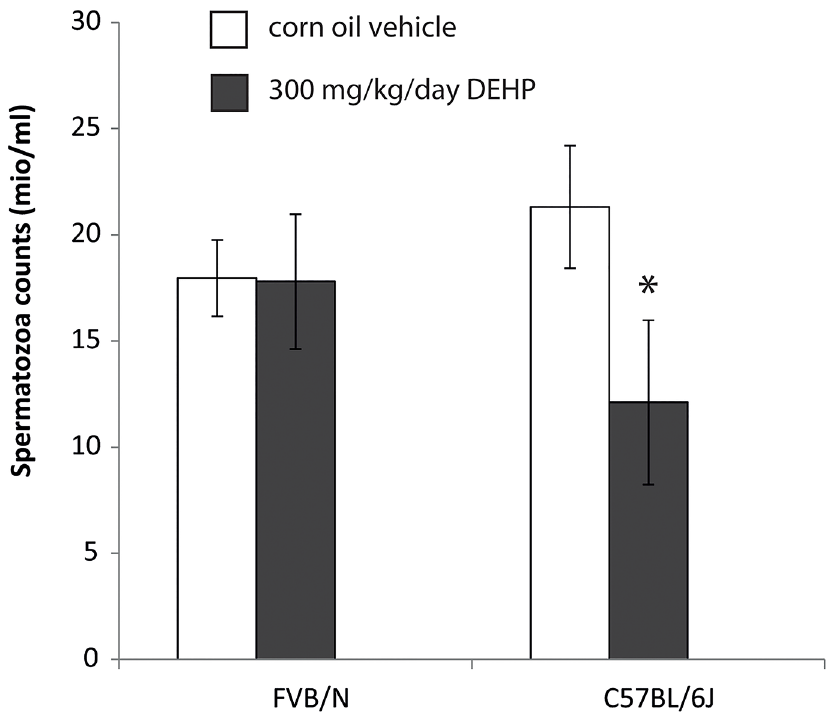
Fig 1. Production of spermatozoa in 8 weeks-old F1 males prenatally exposed to DEHP. Histogram plot showing on the y-axis the spermatozoa count expressed as millions spermatozoa per milliliters (mio/ml) recorded from sperm of F1 males mice, and on the x-axis, the two genetic backgrounds studied with either prenatal exposure to 300 mg/kg/day DEHP diluted in corn oil (gray bars), or corn oil vehicle only (white bars). Prenatal exposure consists of oral administration during pregnancy days 9 to 19 to the pregnant mice childbearing the future F1 males. Errors bars represent standards deviation. * Statistical significant T-test performed between counts recorded in C57BL/6J controls compared with C57BL/6J DEHP treated (Mean C57BL/6J CTL = 21.3, mean C57BL/6J DEHP 300 = 12.1, t = 5, df = 8, p-value = 8.7 * 10 − 4